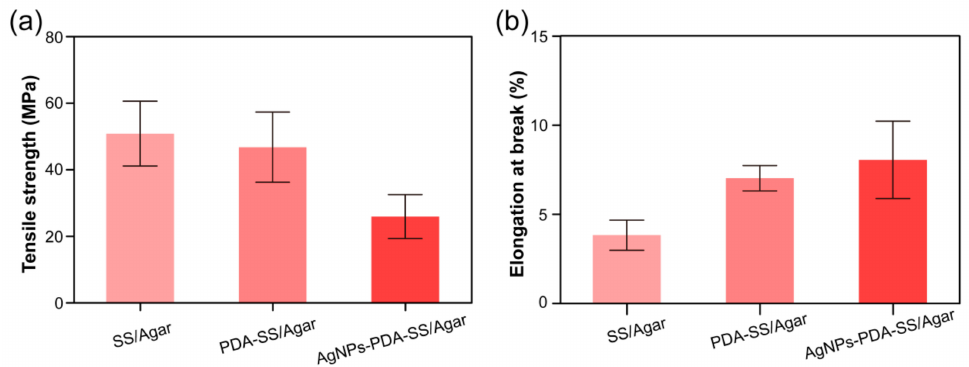
Figure 6. Mechanical properties of different films: ( a ) tensile strength, and ( b ) elongation at